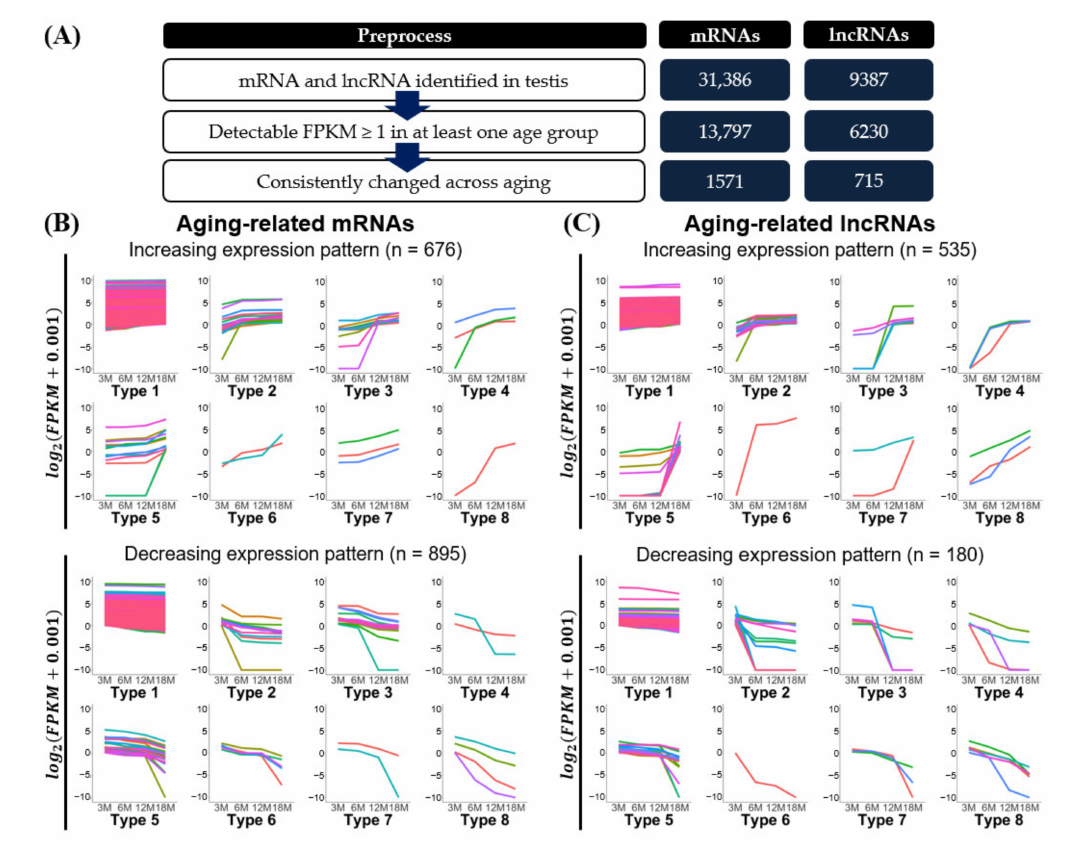
Figure 3. Expression change patterns of aging-related transcripts. ( A ) Preprocessing of identified mRNAs and lncRNAs was used to classify expression patterns. Expression change patterns of aging-related ( B ) mRNAs and ( C ) lncRNAs are described in line plots. Discrete colored lines represent each transcript. Expression levels are presented as log 2 (FPKM + 0.001). Expression patterns were classified into eight different types. Details of the expression pattern classification are shown in Table 2 and Supplementary Tables